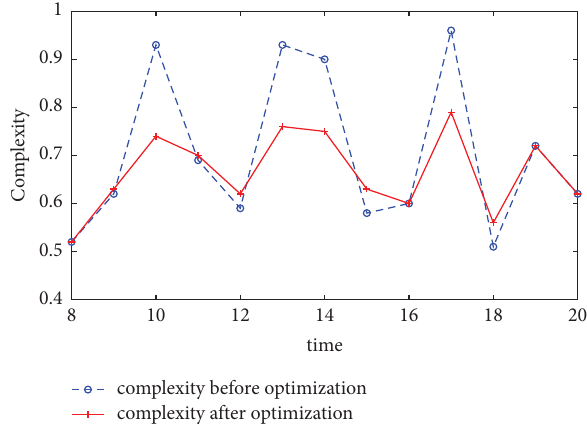
Figure 17: Comparison chart of complexity before and after optimization.